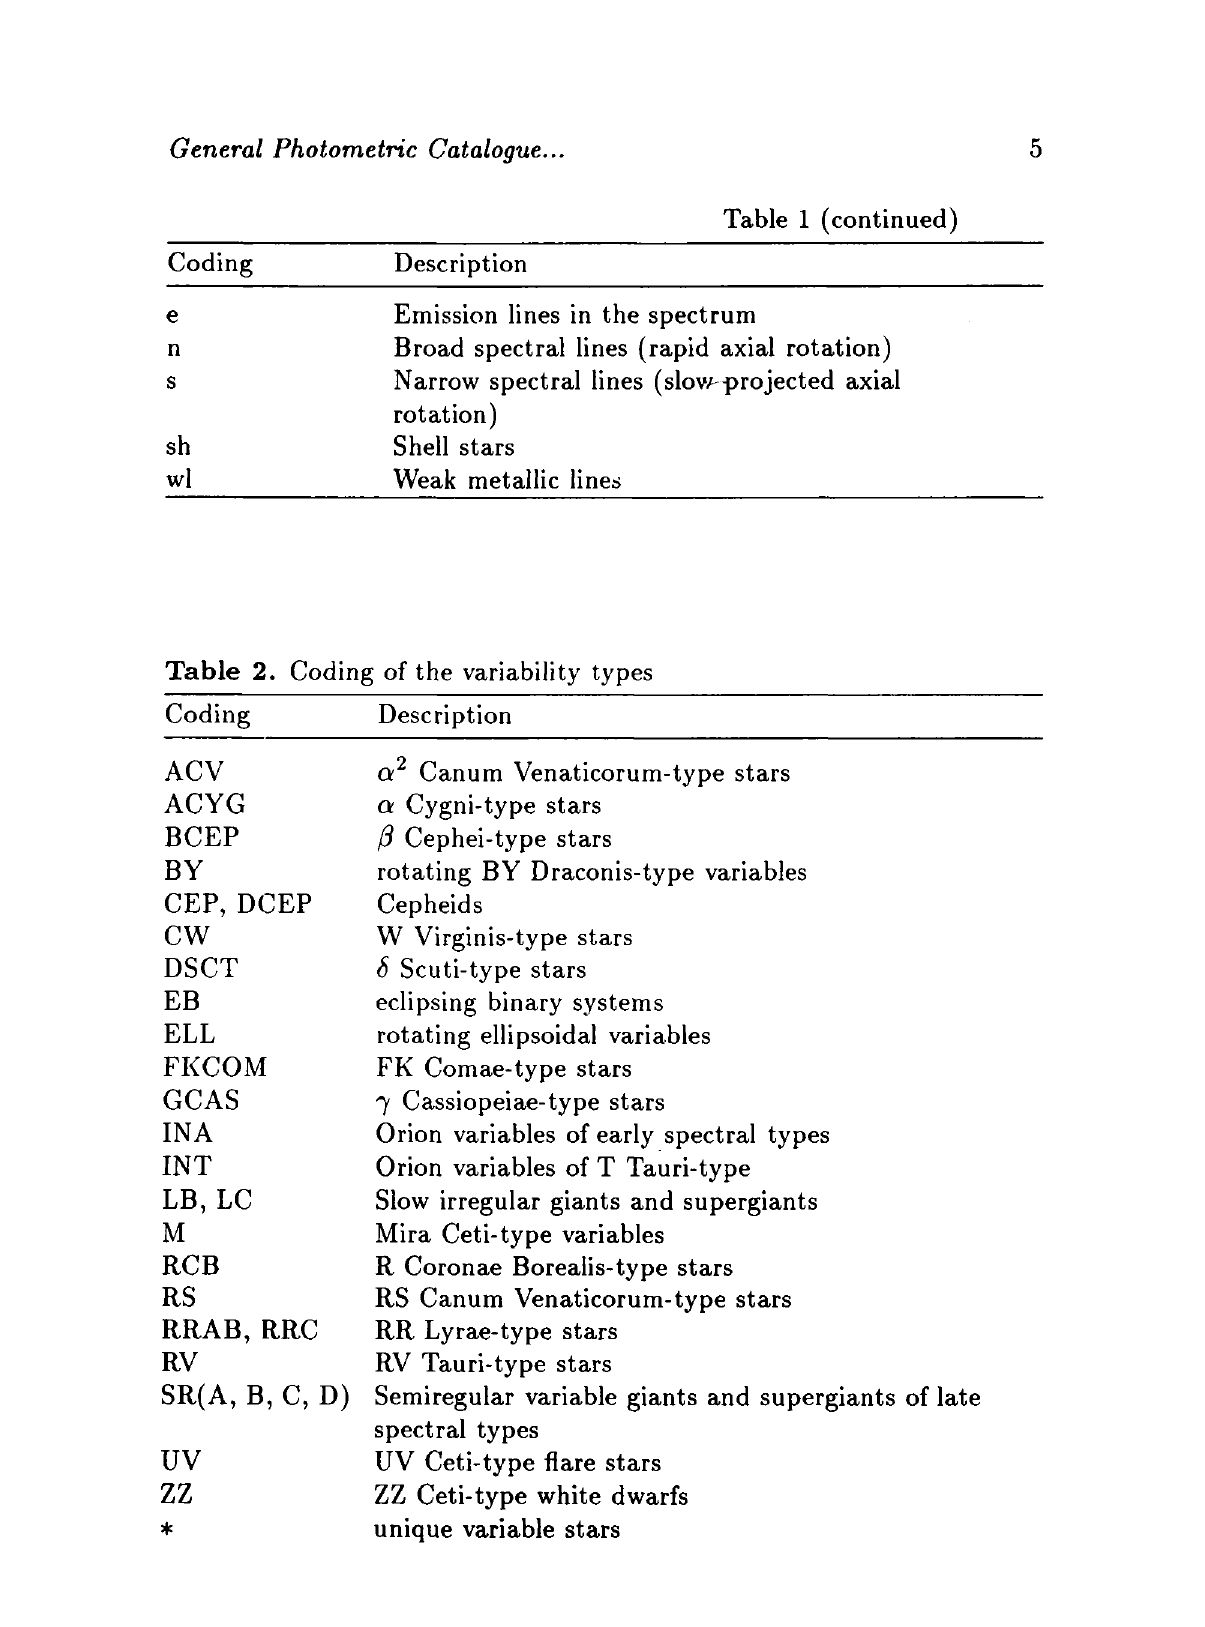
Table 2. Coding of the variability